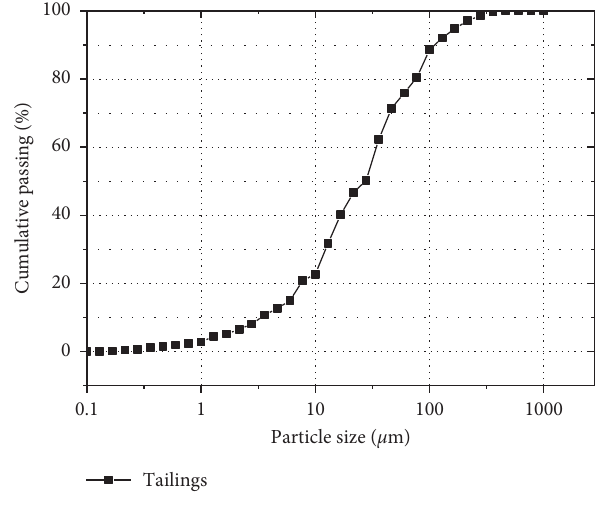
Figure 1: Granularity composition of tailings. Table 1: Parameter design of floc shear